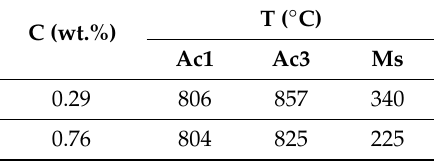
Figure 1. Relative change in length (RCL) as a function of T during 0.18 ◦ C / s heating up to 1000 ◦ C and subsequent cooling down to room temperature, 100 ◦ C / s, for both alloys. Table 2. Critical temperatures of the tested alloys, obtained by high-resolution dilatometry. C